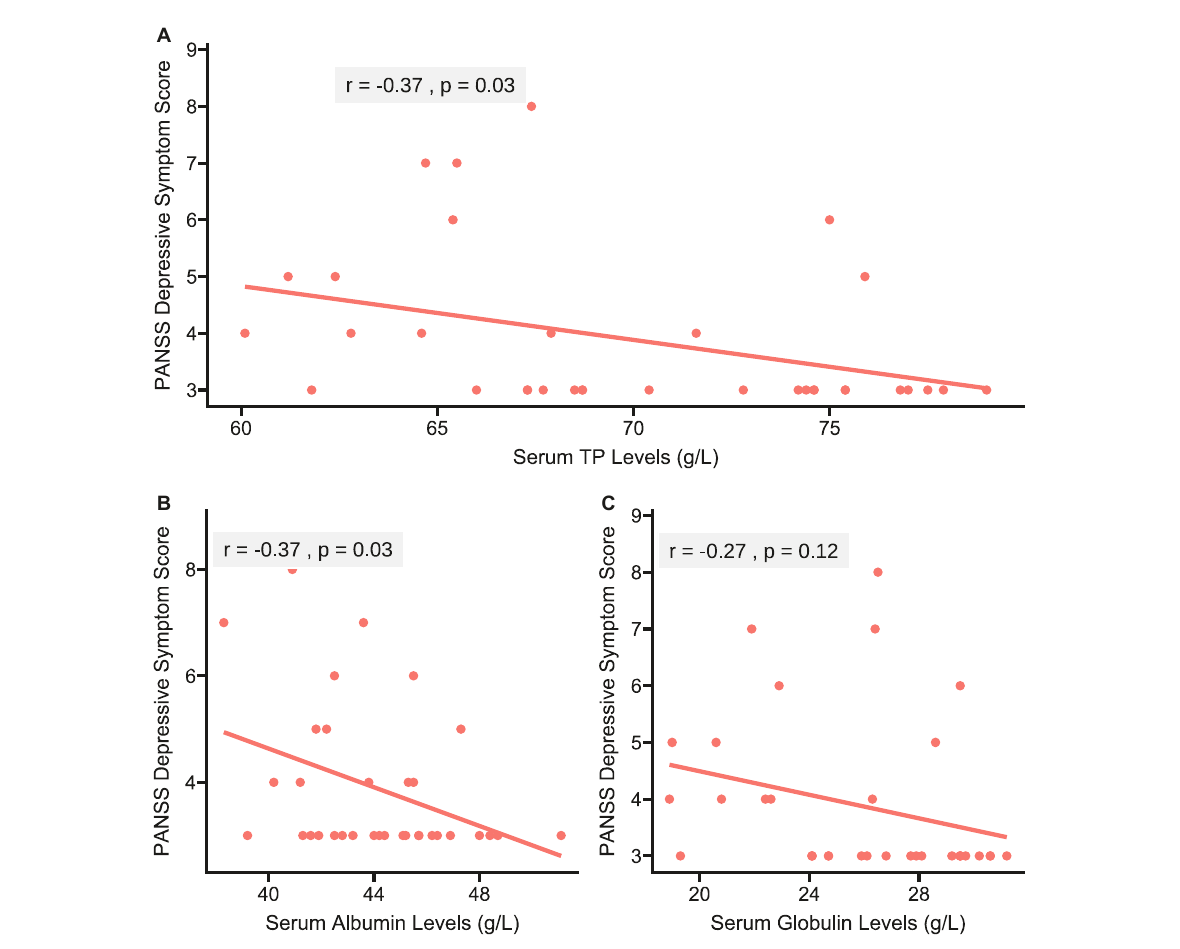
FIGURE2 Correlations of serum TP, albumin, and globulin concentrations with depressive score in patients with SCH, respectively. (A) A negative correlation of serum TP concentration with depressive score was found in patients with SCH ( r = –0.37, p = 0.03); (B) a negative correlation of serum albumin concentration with depressive symptom score was found in patients with SCH ( r = –0.37, p = 0.03); and (C) serum globulin concentration was not correlated with depressive score in patients with SCH ( r = –0.27, p = 0.12). PANSS, the Positive and Negative Syndrome